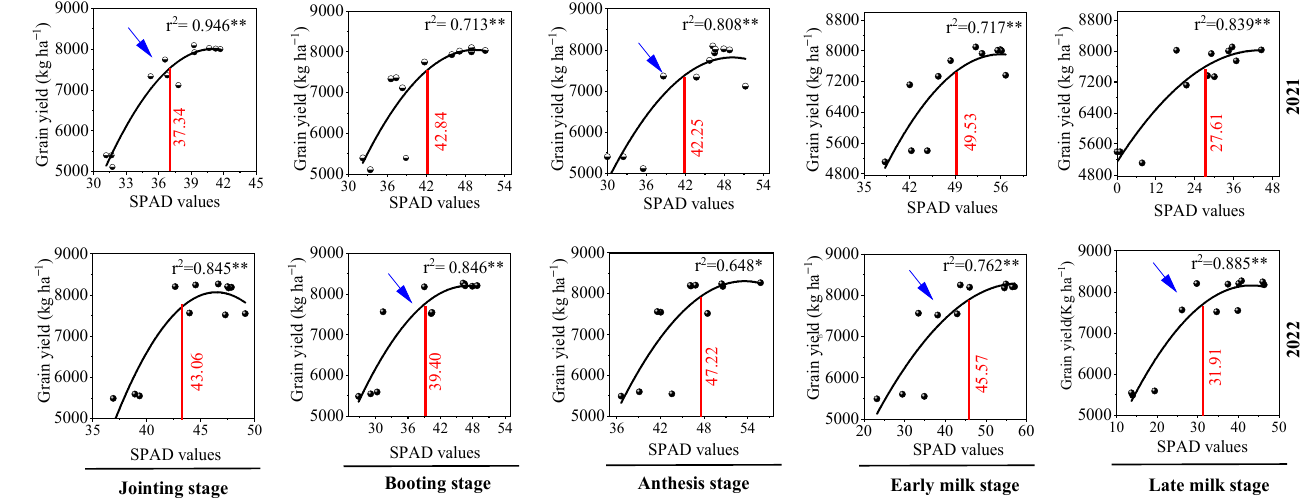
Figure 4. The relationship between SPAD values and grain yield of wheat. The SPAD values were measured in the middle of first top leaf (L1–M) of wheat. Red lines represent the SPAD values of the maximum theoretical yield of 95%, and red numbers represent the critical SPAD values. * and ** indicate significant differences at 0.05 and 0.01 levels, respectively. Blue arrows represent the function that has higher correlation coefficient (r 2 ) between SPAD values and grain yield at the same growth stage in different years.